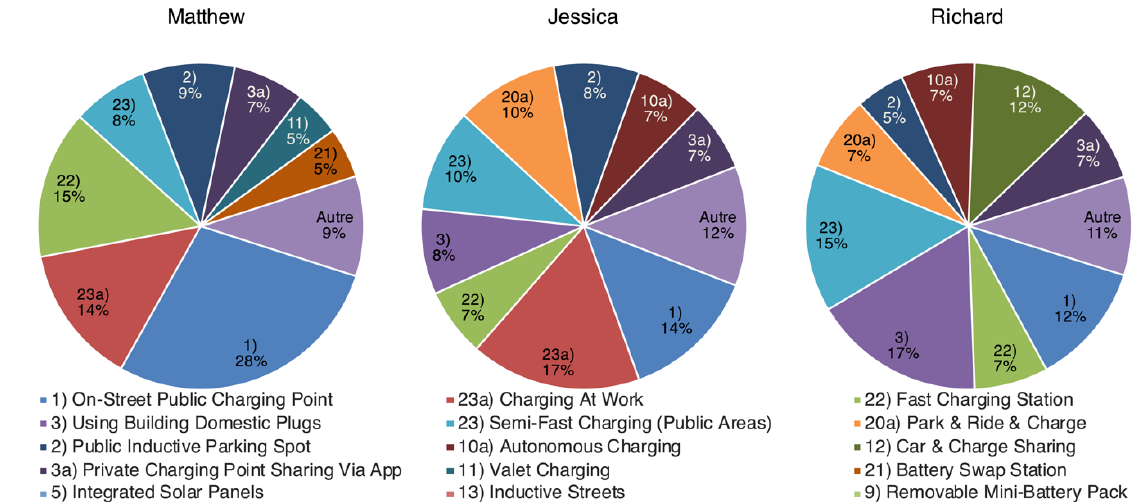
Figure 7. Preferred mix of recharge solution for each user